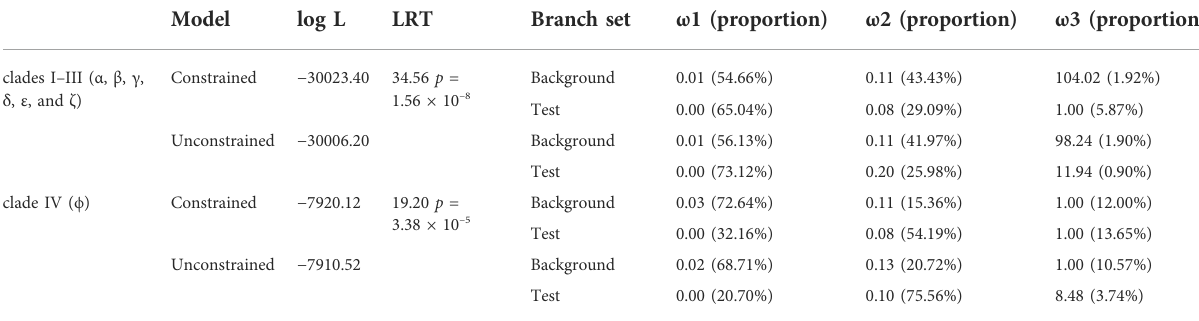
TABLE 1 The branch-site unrestricted statistical test for episodic diversi fi cation (BUSTED) results for moss PLDs .